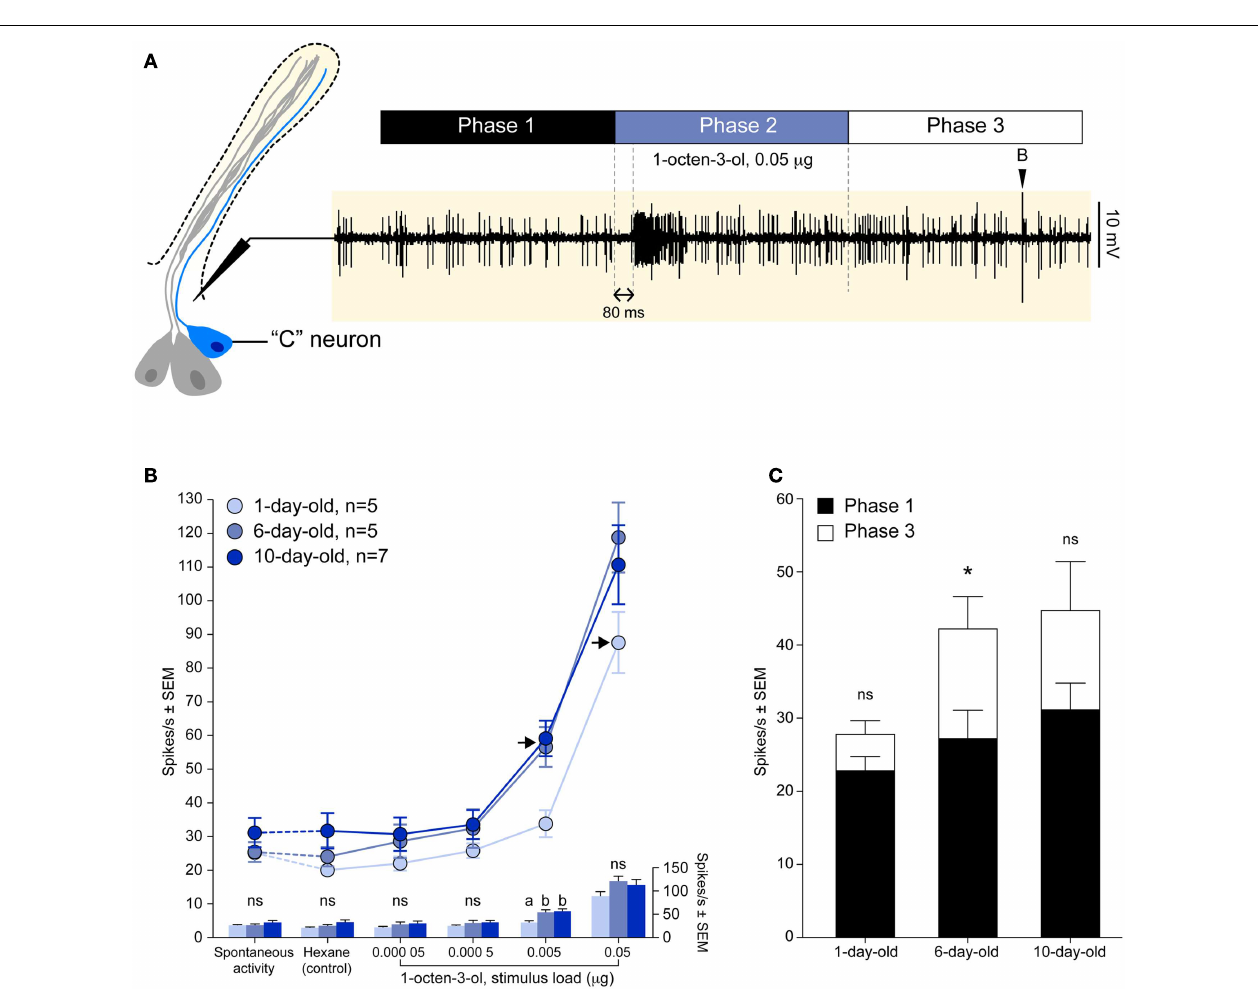
compared to hexane control using a one-way ANOVA followed by Dunnett’s post test (*** P < 0.001; ** P < 0.01; ns, not significant). Detection threshold for 1day old and 6/10days old insects was 0.05 and 0.005 µ g, respectively (black arrows).The histograms below shows the comparison of the mean responses for each concentration (one-way ANOVA followed byTukey’s multiple comparison post test, P < 0.05; ns, not significant). (C) The rate of spontaneous activity pre-stimulation (phase 1) and post-stimulation (phase 3) showed a significant change for 6days old insects (Student t test, * P < 0.05; ns, not